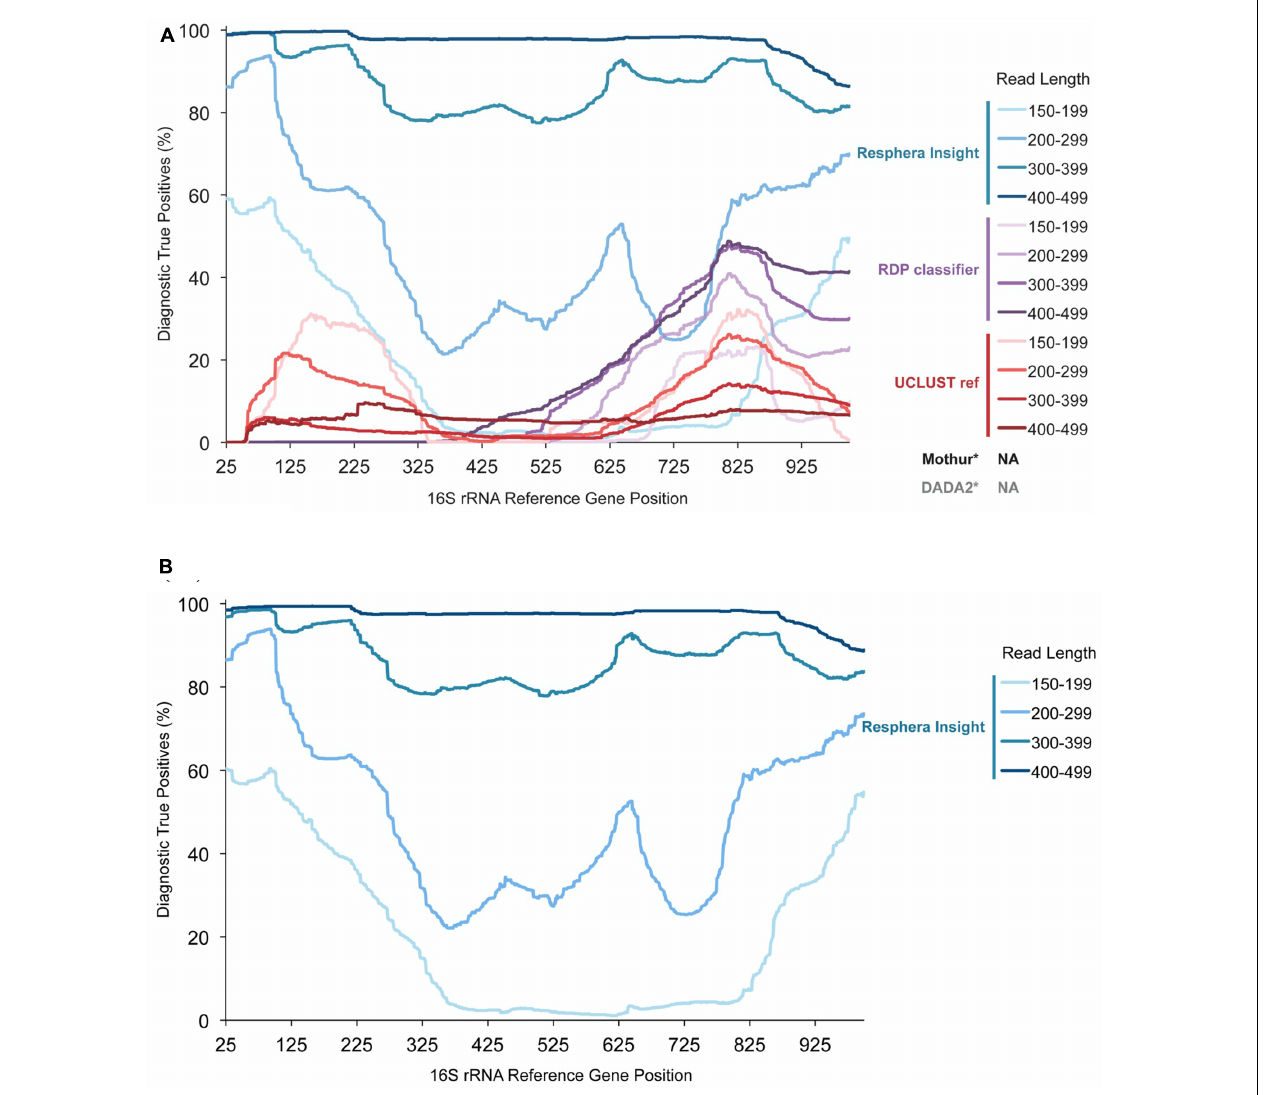
FIGURE 1 | Salmonella enterica Diagnostic True Positive Rate of Resphera Insight and 2 other taxonomy assignment tools. (A) . Performance of the Insight method and other tools on 512 isolates of S. enterica . (B) . Expanded validation of Resphera Insight on 12,090 isolates of S. enterica . Y -axis shows the Diagnostic True Positive Rate (DTP), i.e., the percentage of sequences assigned unambiguously to S. enterica . Lines display the average DTP for all reads covering each gene position for a given read length range. DTP rates are improved for Resphera Insight with longer sequences that cover the first 250 bp of the 16S rRNA gene. ∗ The default versions of Mothur and DADA2 do not generate species level